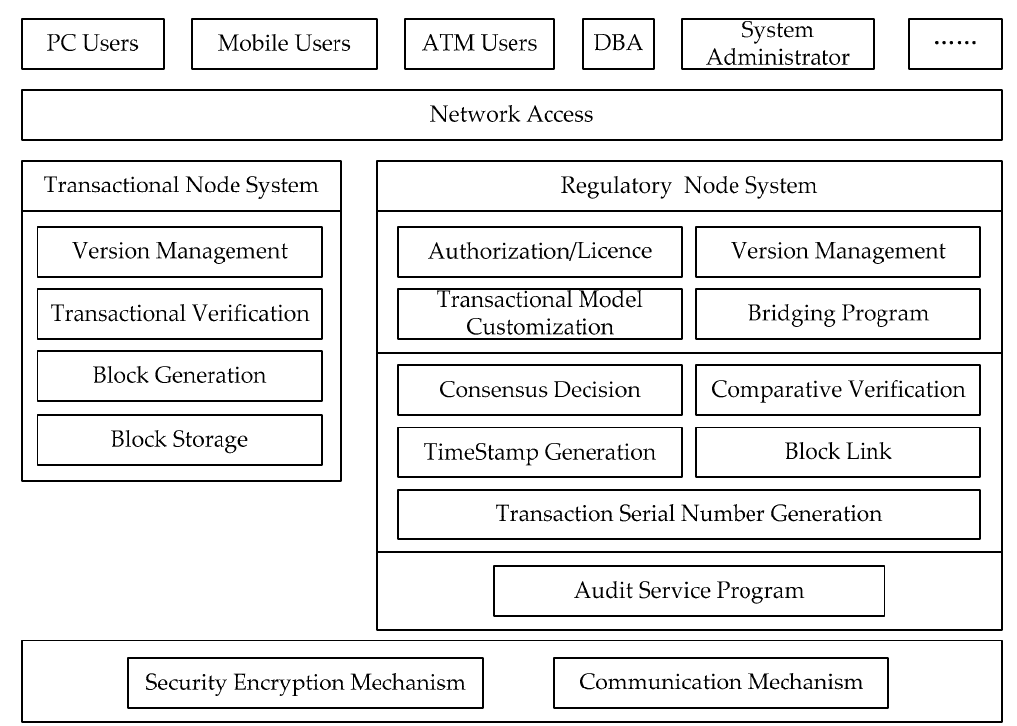
Figure 1. The overall architecture diagram of MTMCB.